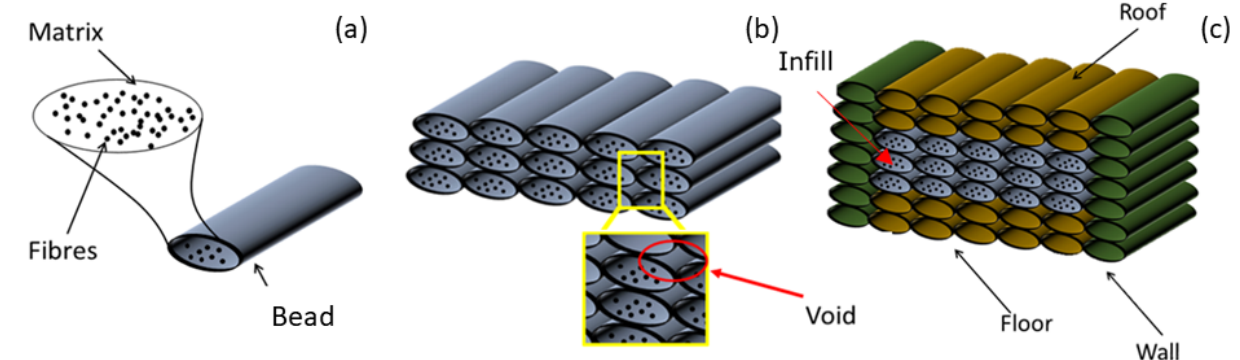
Figure 1. Example of the printing process of an FFF reinforced thermoplastic part. ( a ) Single reinforced bead; ( b ) ensemble of reinforced beads (infill); ( c ) infill enclosed in protective cover constituted by the roof, floor, and wall layers [2].